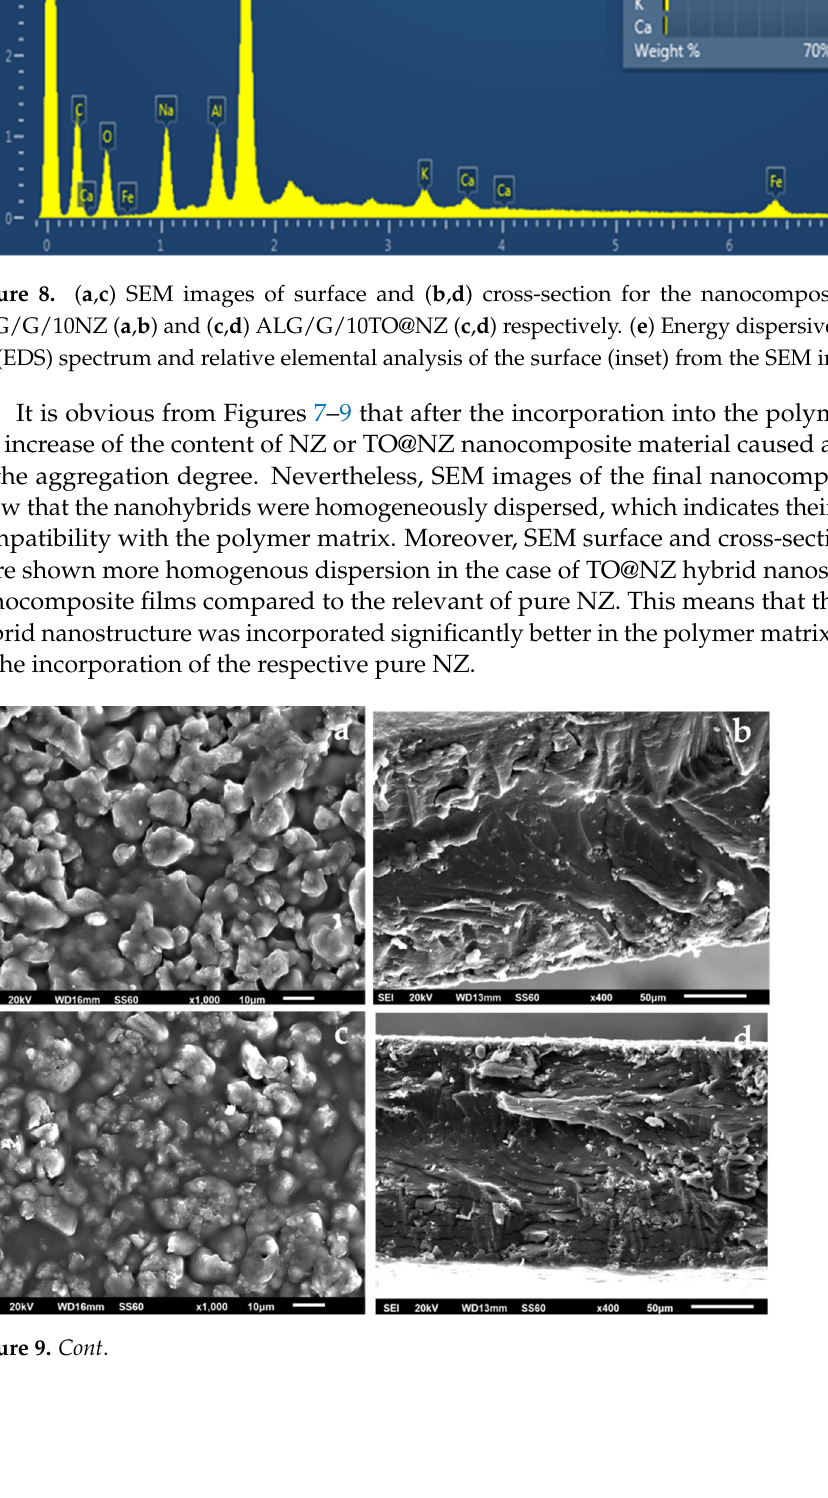
Figure 9. ( a , c ) SEM images of surface and ( b , d ) cross-section for the nanocomposite films of ALG/G/15NZ ( a , c ) and ALG/G/15TO@NZ ( c , d ) respectively. ( e ) Energy dispersive spectrometer (EDS) spectrum and relative elemental analysis of the surface (inset) from the SEM image ( a ). It is obvious from Figures 7–9 that after the incorporation into the polymer matrix, the increase of the content of NZ or TO@NZ nanocomposite material caused an increase to the aggregation degree. Nevertheless, SEM images of the final nanocomposite films show that the nanohybrids were homogeneously dispersed, which indicates their en- hanced compatibility with the polymer matrix. Moreover, SEM surface and cross-section images were shown more homogenous dispersion in the case of TO@NZ hybrid nanostructure in nanocomposite films compared to the relevant of pure NZ. This means that the TO@NZ hybrid nanostructure was incorporated significantly better in the poly- mer matrix compared to the incorporation of the respective pure NZ. 2.6. Tensile Properties The calculated values of elastic modulus (E), ultimate strength ( σ uts ), and elongation at break (% ε ) for all ALG/G/xNZ and ALG/G/xTO@NZ nanocomposite films are listed in Table 1.